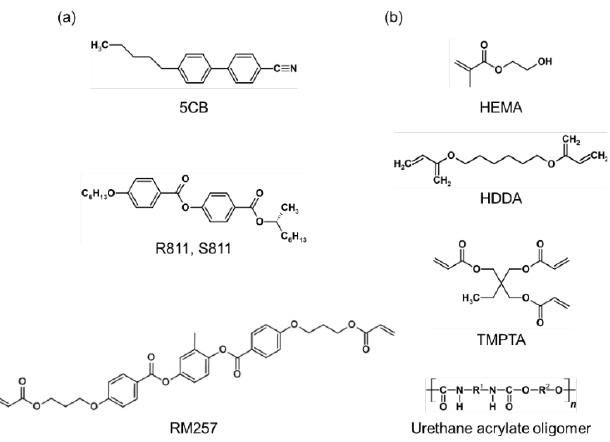
Figure 1. Chemical structures of materials used for fabricating the CLC-PUA composite film. ( a ) The chemical structures of liquid crystalline materials; the small molecular LC (5CB), the chiral dopant (R811 and S811), and the reactive mesogen (RM257). ( b ) The chemical structures of representative components of the PUA prepolymer: HEMA, HDDA, TMPTA, and urethane acrylate